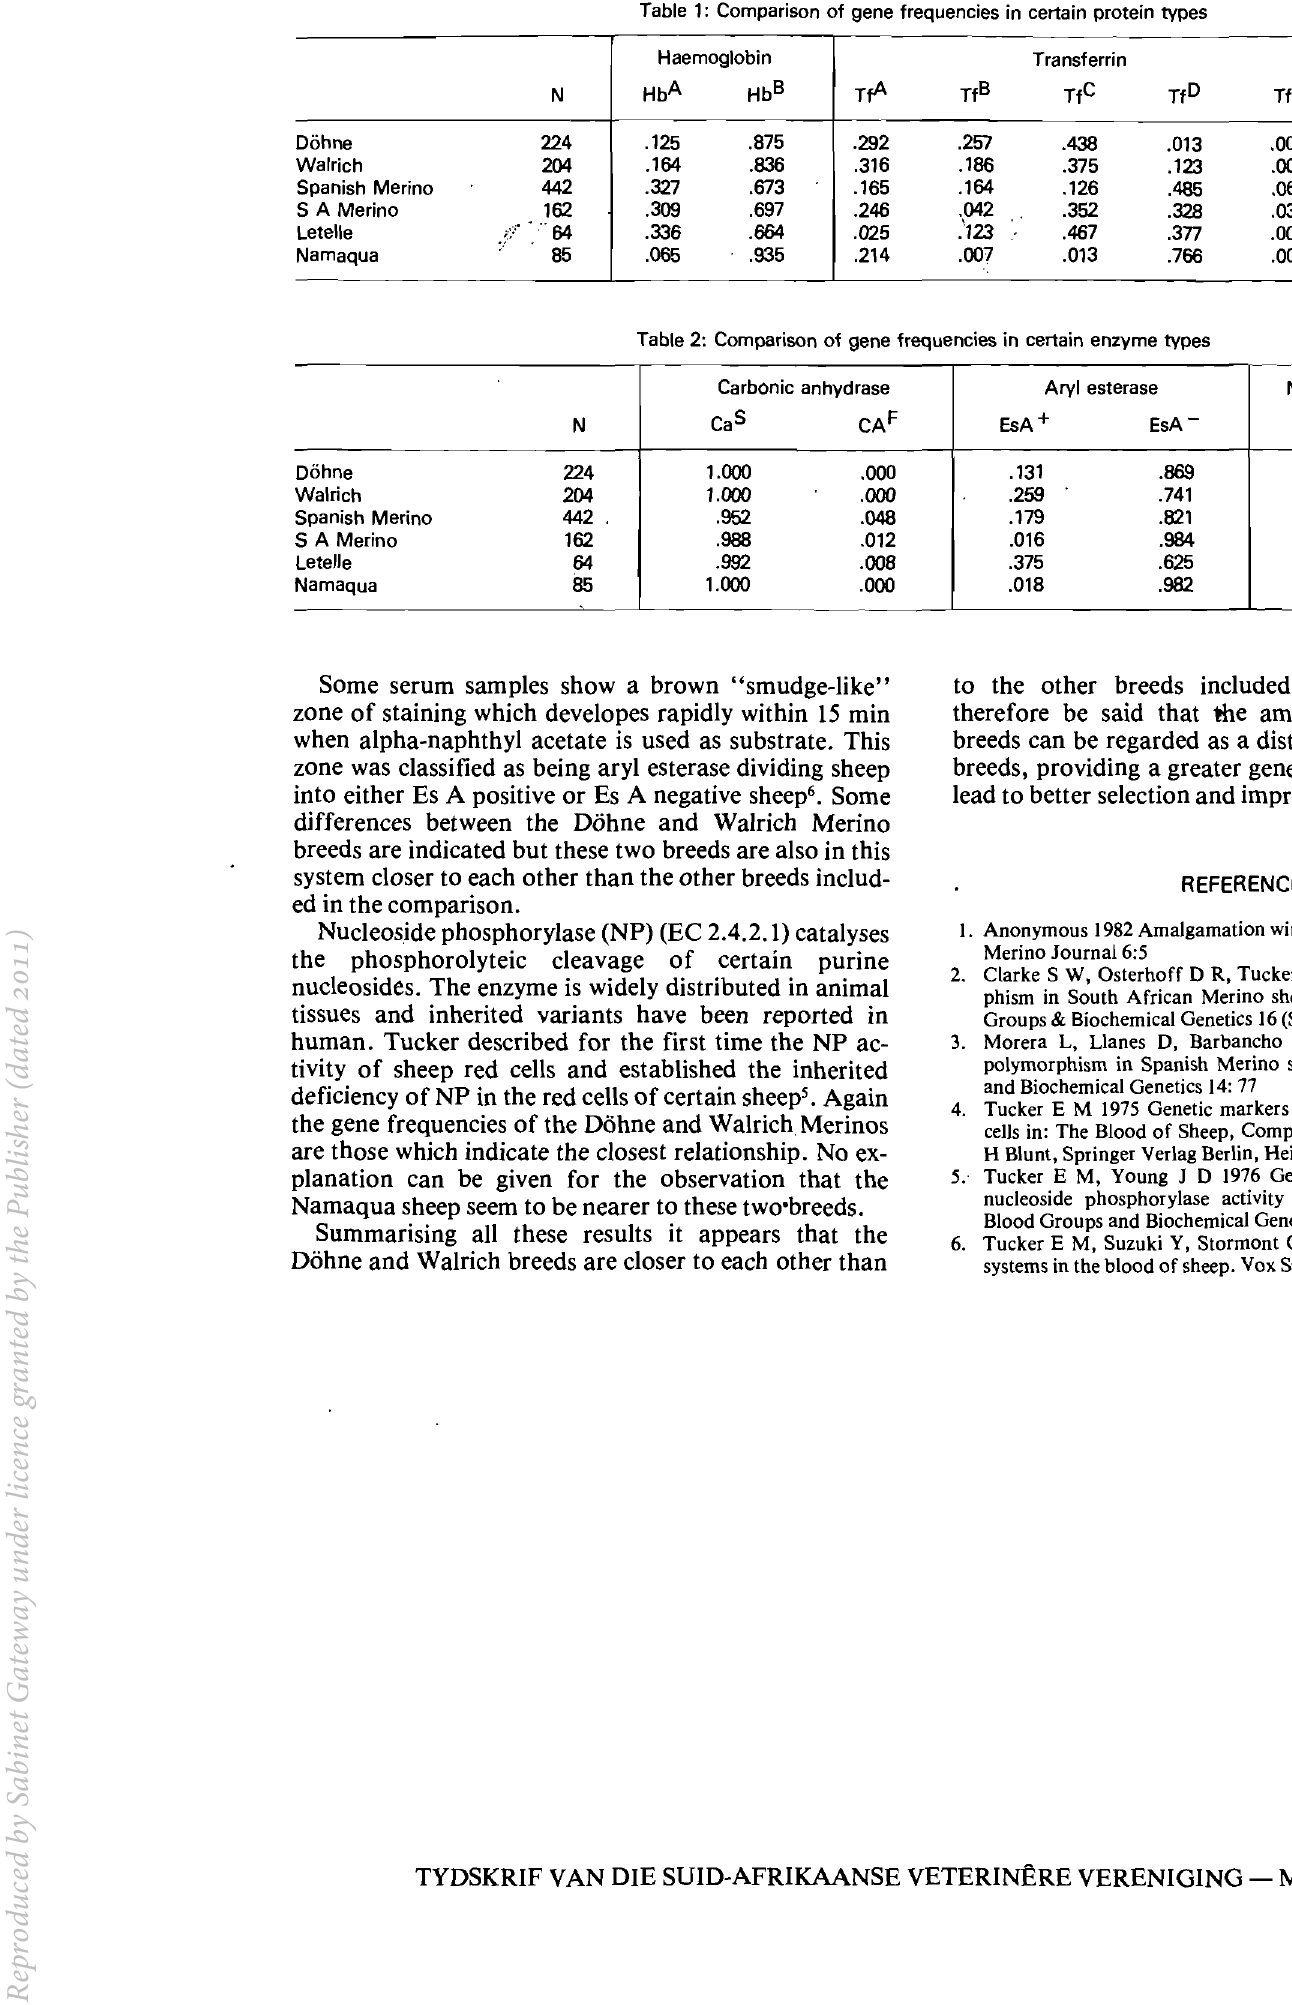
Table 1: Comparison of gene frequencies in certain protein types